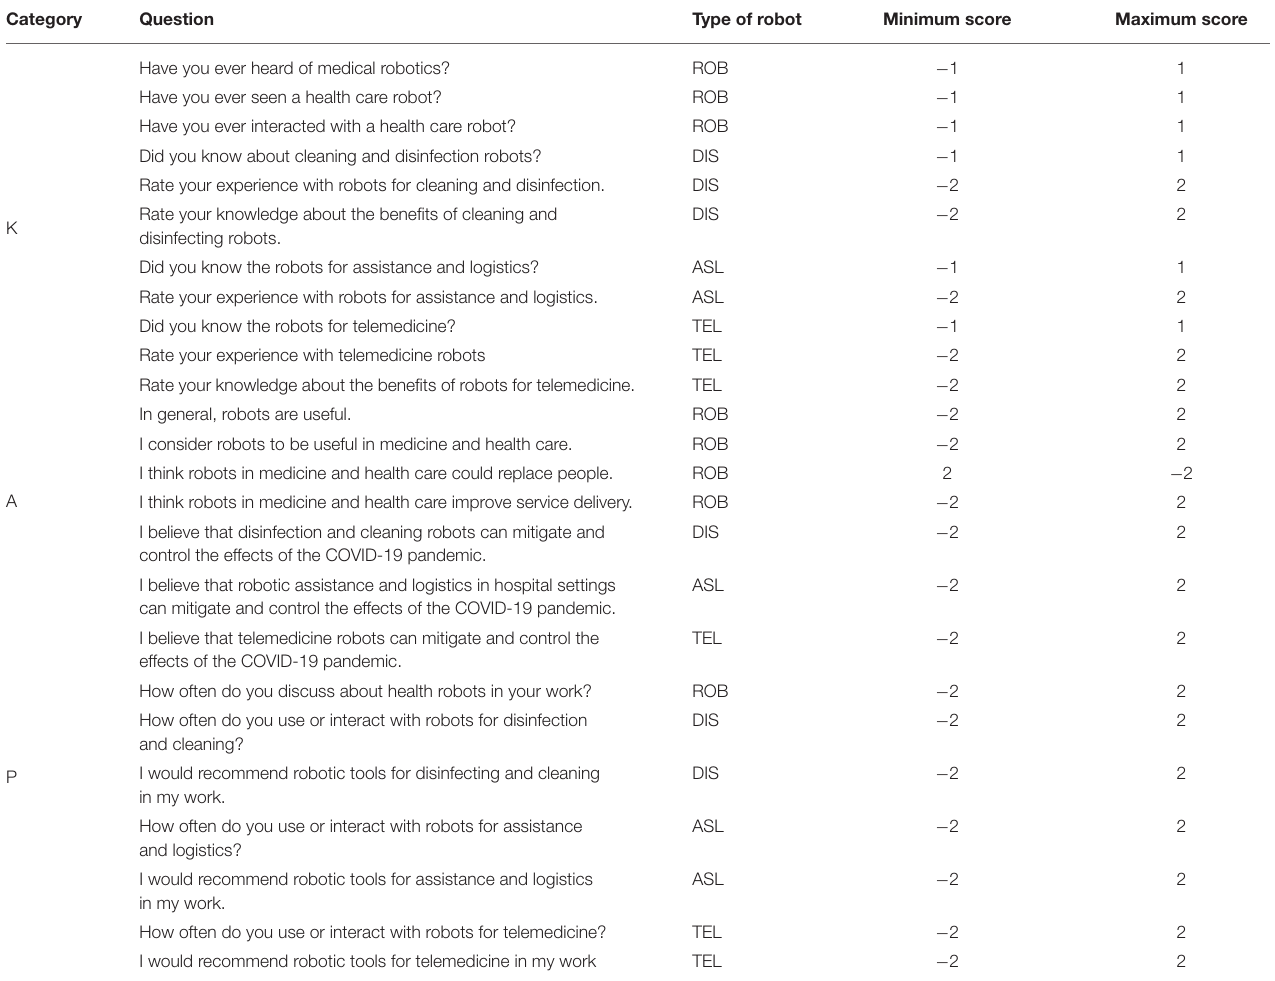
TABLE 2 | Designed questions for the Knowledge, Attitude, Perception (KAP) survey used in this study. Category